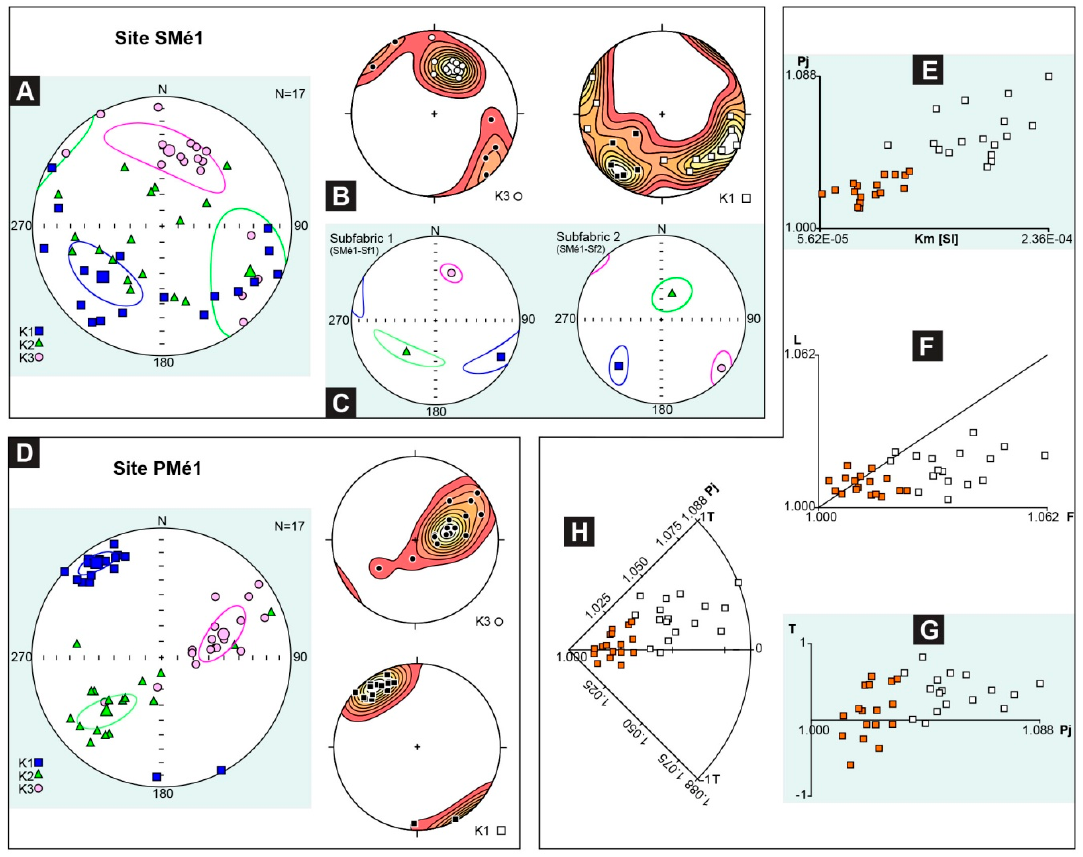
Figure 6. Magnetic fabric of sedimentary (SMé1) and polygenetic (PMé1) mélange specimens: ( A ) stereoplots (lower-hemisphere projections) showing the shapes and attitudes of the magnetic susceptibility ellipsoids from site SMé1; ( B ) density diagrams of k 1 and k 3 axes (contour interval = 10) and ( C ) relative subfabrics; ( D ) and site PMé1 AMS data. Whole diagrams for the measured sedimentary fabric in which white and orange are, respectively, SMé1 and PMé2 data: ( E ) anisotropy degree vs. mean susceptibility; ( F ) magnetic lineation vs magnetic foliation; ( G ) shape parameter vs corrected anisotropy degree;( H ) π /4 segment polar plot (see [103]), in which Pj represents the radius and T the arc length.